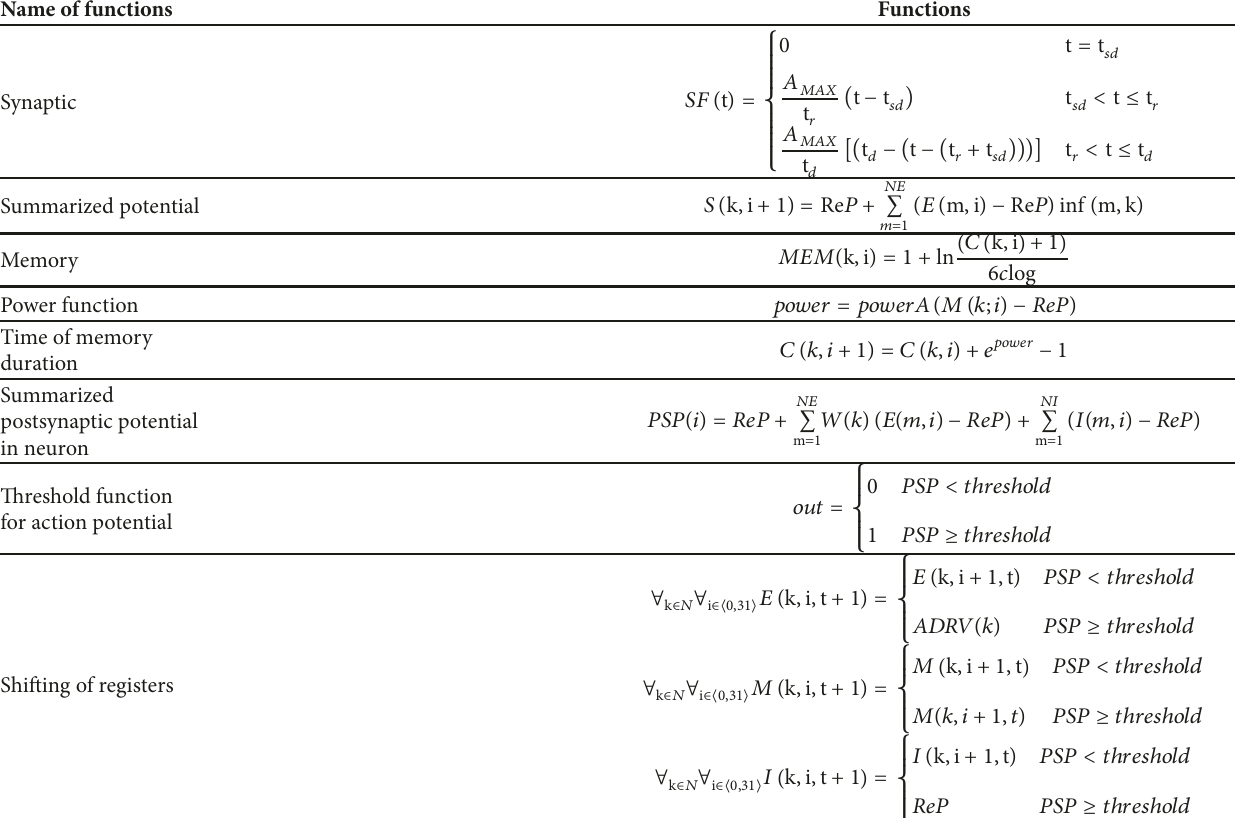
Table 1: The most important mathematical issues of the model cells of CA1 region.